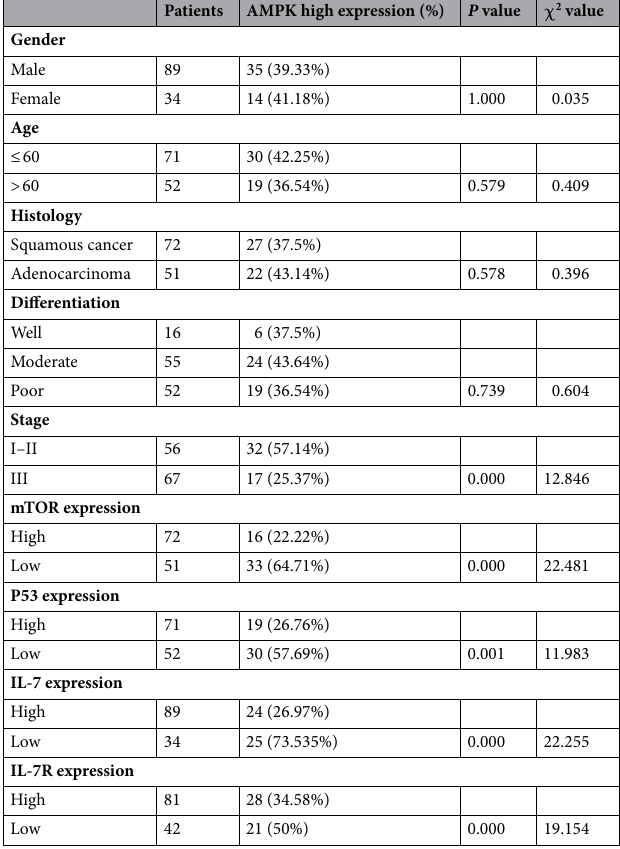
Table 1. Relationship between AMPK expression in NSCLC and clinical pathological factors (Chi-square test).